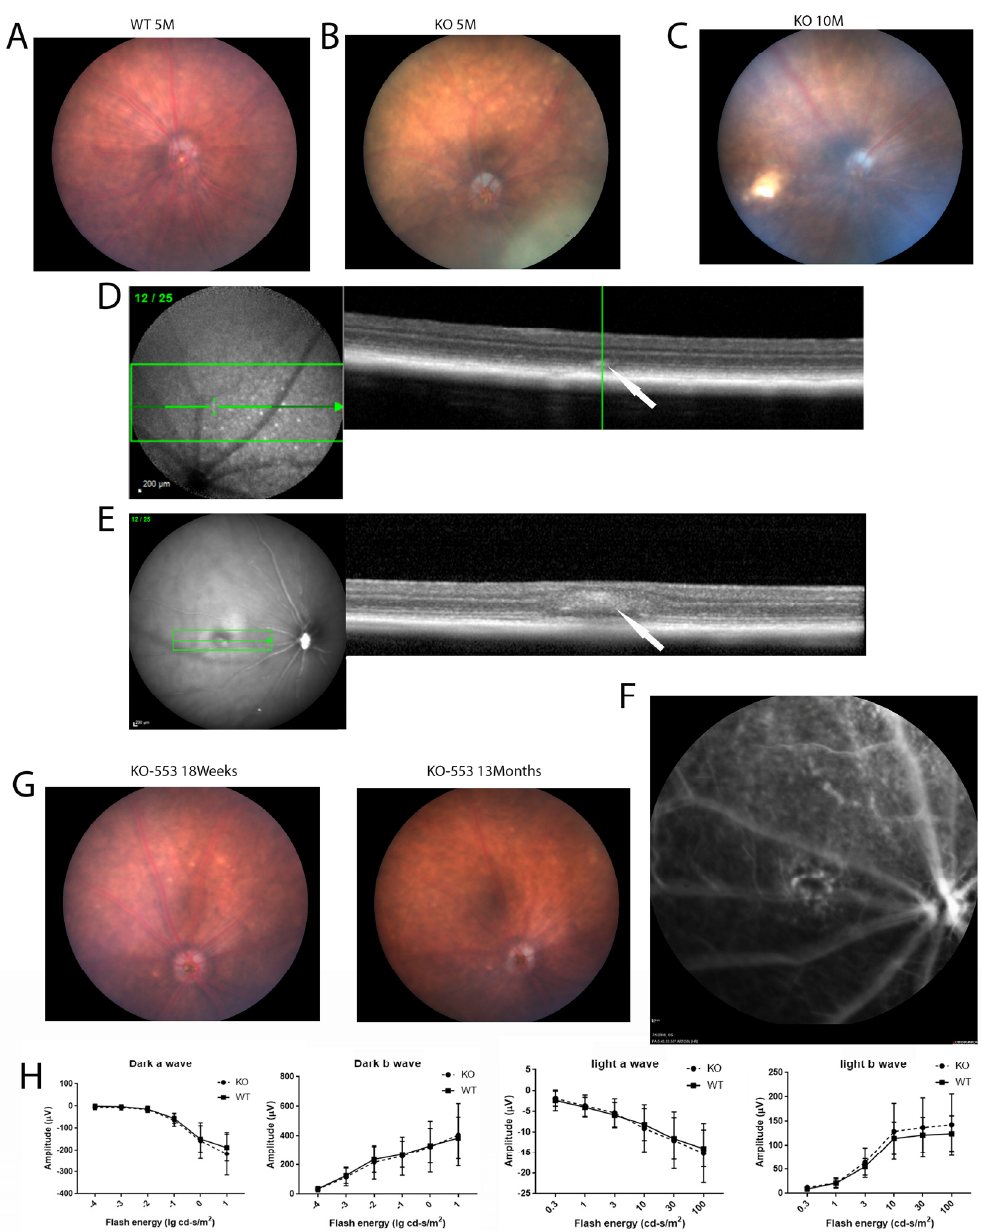
Figure 2. Fundus photography, OCT, and ERG of wild-type and Cyp4v2 KO mice. ( A ). Fundus images and OCT of retina in 5-month-old wild-type mouse. ( B ). Representative fundus image and OCT of 5-month-old KO mouse. ( C ). Representative fundus image of 10-month-old KO mouse, showing a retinal scar consistent with BCD. ( D ). OCT image of the KO mouse shown in ( B ) demonstrates hyperreflective spots in IS/OS of the photoreceptors in knock-out mice, as indicated by the arrow ( E ). OCT image of the KO mouse from ( C ) shows a retinal scar, as indicated by the arrow ( F ). Fluorescent angiogram of the mice shown in ( C ) and ( E ) demonstrates possible choroidal neovascularization below the scar. ( G ) Representative fundus images showing retinal crystals becoming less prominent with age. ( H ) Scotopic and photopic ERGs of 13-month-old knockout mice (N = 14) compared to wild type (N = 16).